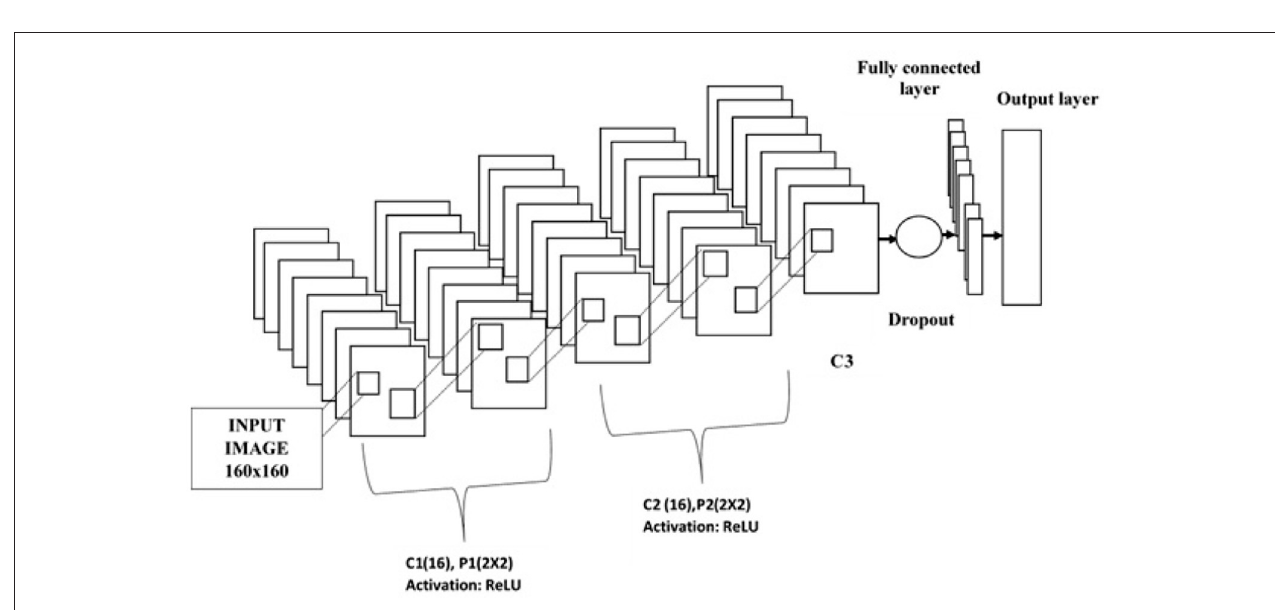
FIGURE 3 | Convolutional neural network.